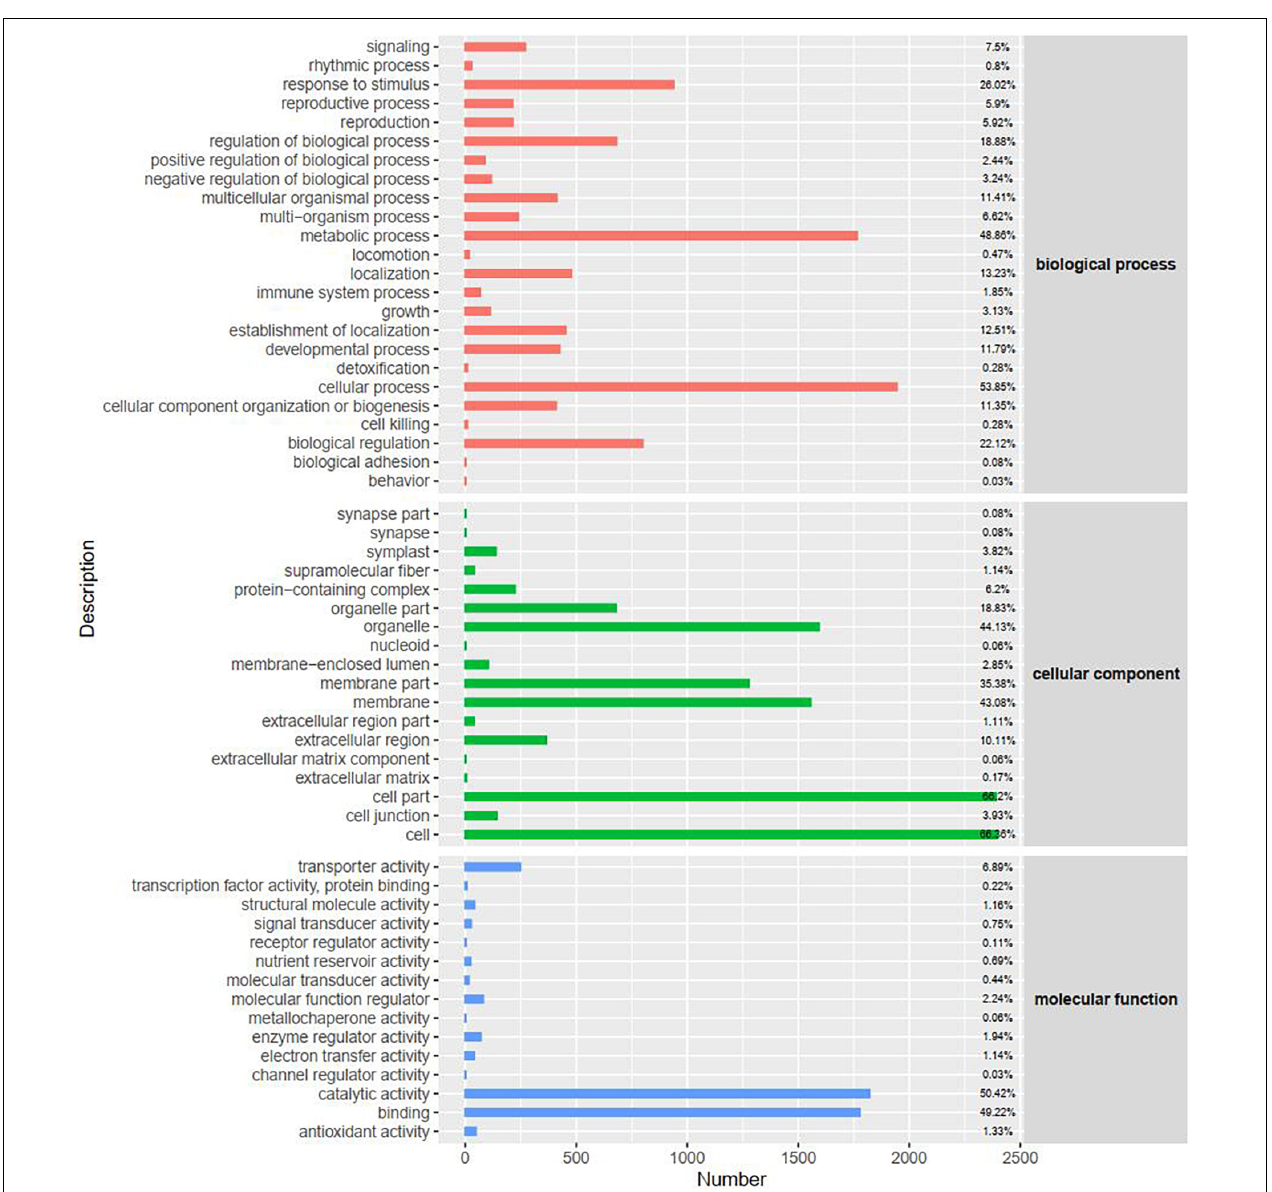
FIGURE 4 | Gene Ontology (GO) classification of DEGs at 48 h. The x -axis represents the number of DEGs.